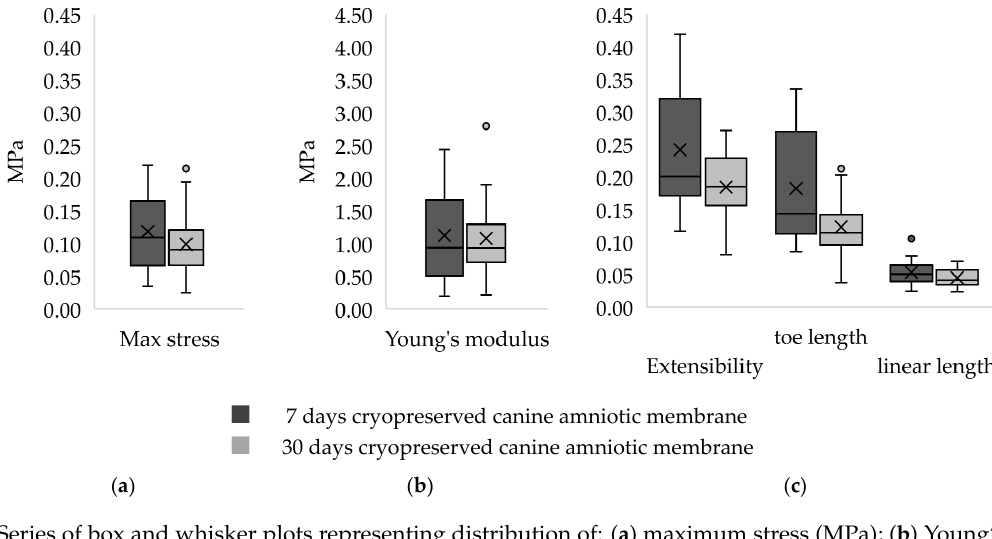
Figure 2. Series of box and whisker plots representing distribution of: ( a ) maximum stress (MPa); ( b ) Young’s modulus (MPa); ( c ) extensibility, toe length, and linear length of canine amniotic membranes after 7 days and 30 days of cryopreservation. The plots show skewed distribution as the mean values (X marks) are not equal to the median values (middle lines) with a few outliers (o marks). The boxes represent the interquartile range while the ends of whiskers represent the maximum and minimum value of the data. Table 1. Median ± interquartile range of tensile strength parameters of canine amniotic membranes that were cryopreserved for 7 days and 30 days.